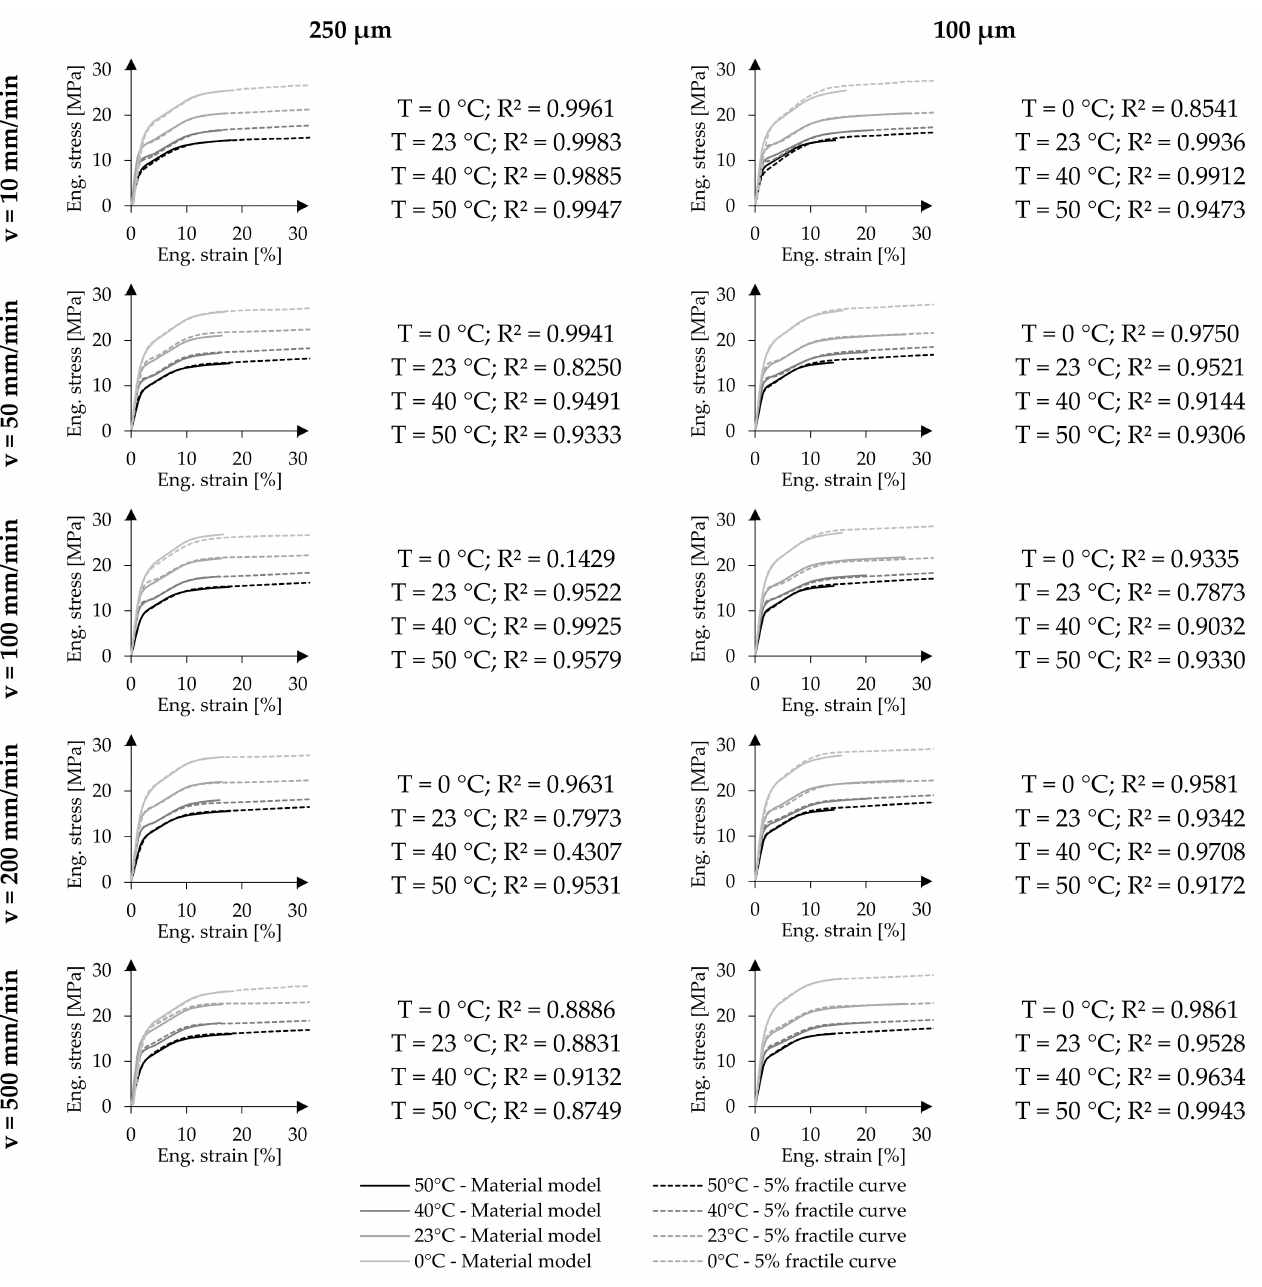
Figure 11. Predicted uniaxial material behaviour of 250 µ m and 100 µ m ETFE foils under uniaxial tension at varying test temperatures and strain rate with their comparison to 5% fractile